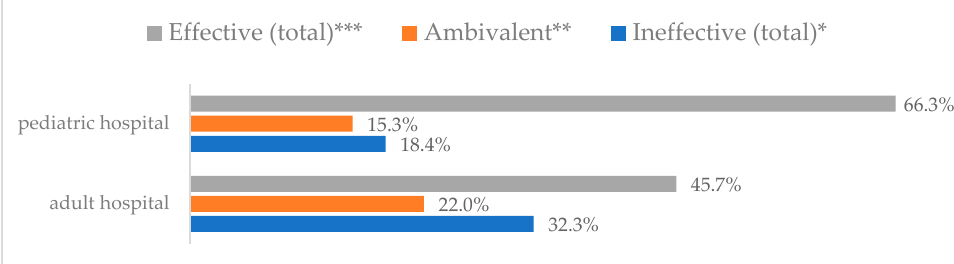
Figure 13. Influenza vaccination to prevent influenza virus infection by type of hospital ( N = 905). *Sum of responses: completely ineffective, ineffective, rather ineffective; **Response: neither inef- fective nor effective; ***Sum of responses: rather effective, effective, completely effective.